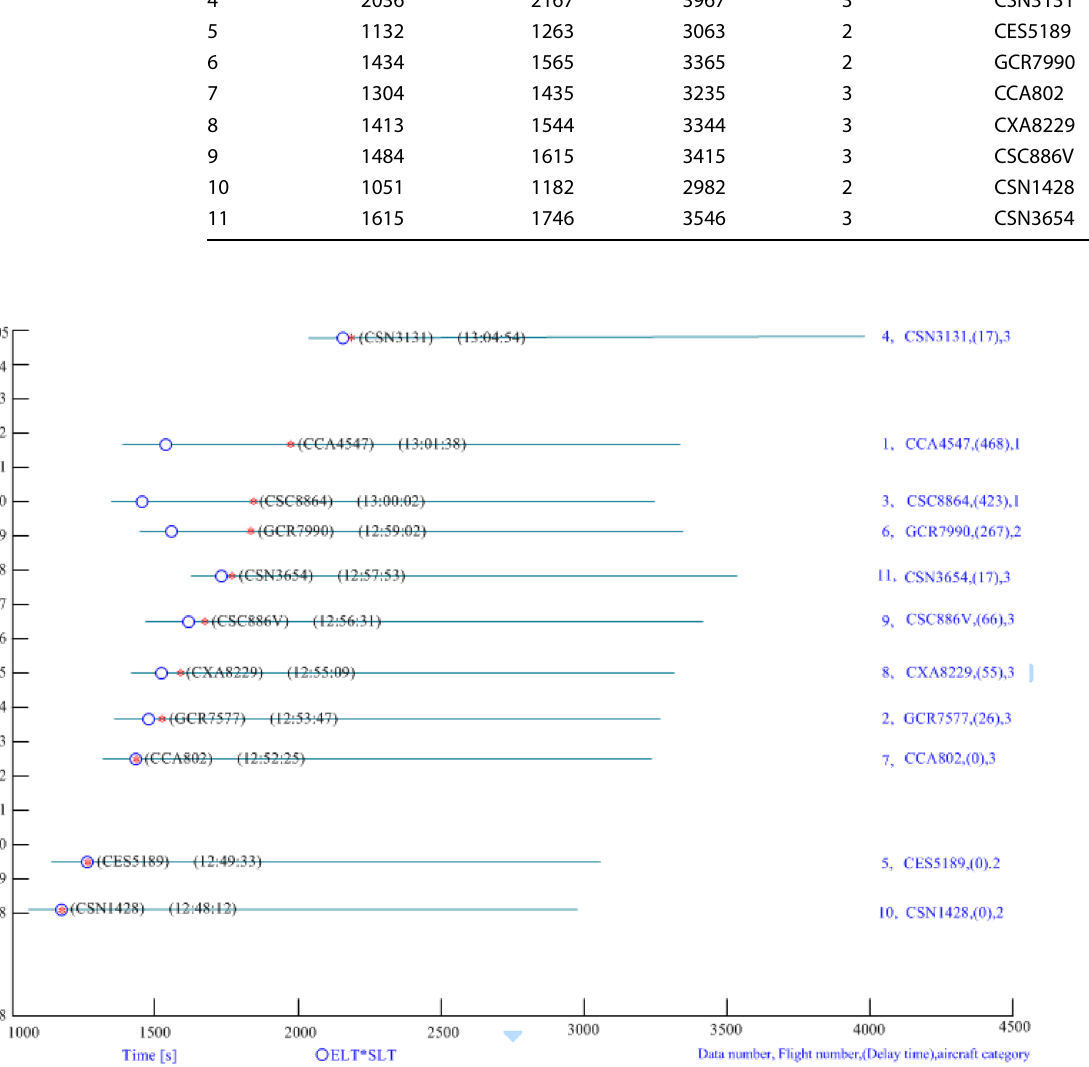
Fig. 2 The arrival sequence and the scheduled landing instant of